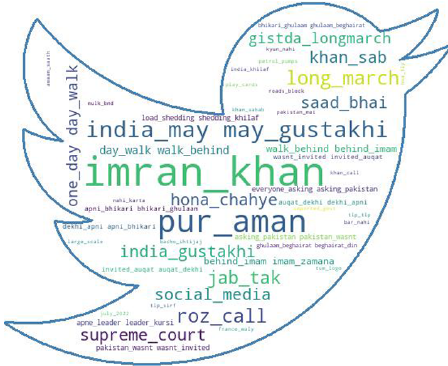
Figure 2. Bigram with negative